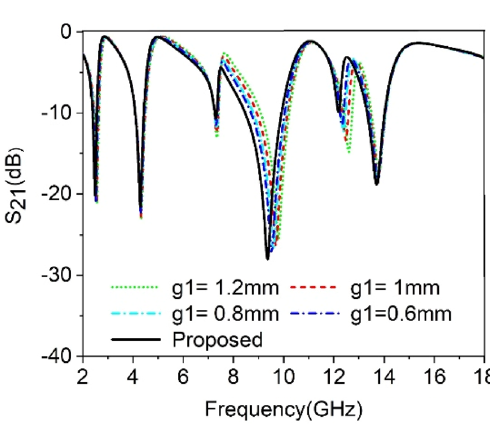
Figure 5. ( a ) S 21 for horizontal and vertical polarization of the incident wave ( b ) S 21 response for different oblique incident angle (θ).